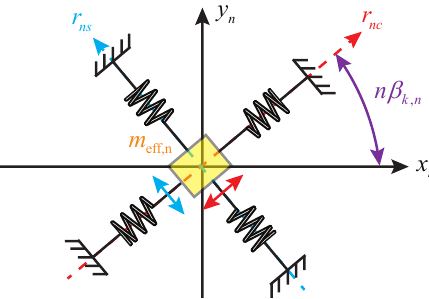
Figure 4. The lumped mass model of a circular resonator in